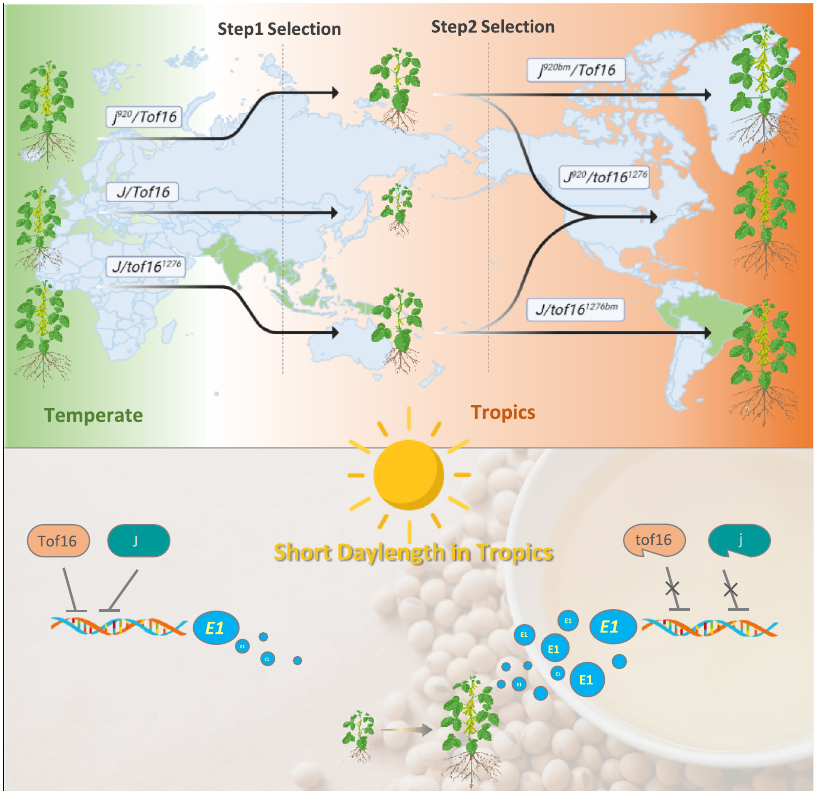
Fig. 5 Evolutionary trajectory of Tof16 and J during low latitude adaptation. Arti fi cial stepwise selection on the various mutational alleles of tof16 and j helps soybean gradually adapted into tropics from its temperate origins. Weak mutant alleles for both tof16 and j were fi rstly selected, and additional null alleles were subsequently acquired in addition to these weak alleles and further selected. Tof16 and J proteins directly bind to the promoter of E1 gene to suppress its transcription. When the protein function of Tof16 and J is damaged, the transcriptional suppression of E1 is released, ultimately resulting in delay fl owering and maturity and enhance grain